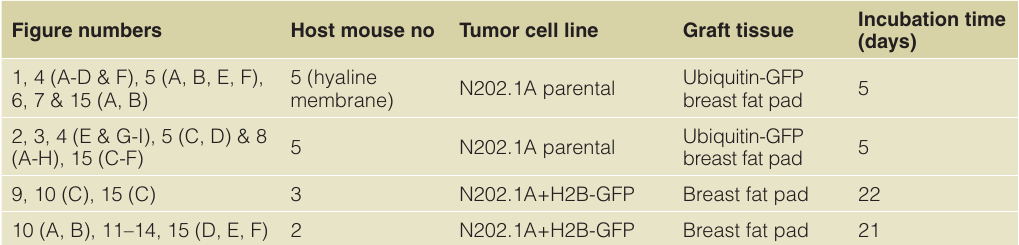
Table 1. Experimental